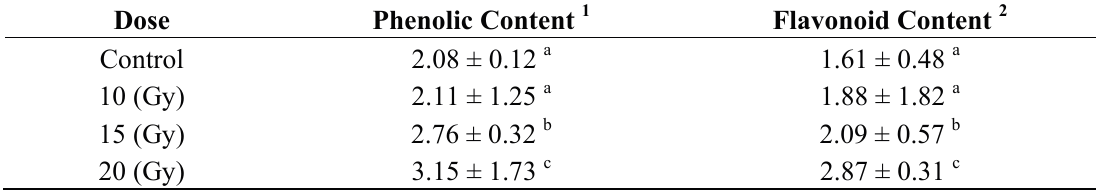
Table 1. Total phenolics and flavonoids content in the leaves of C. alismatifolia